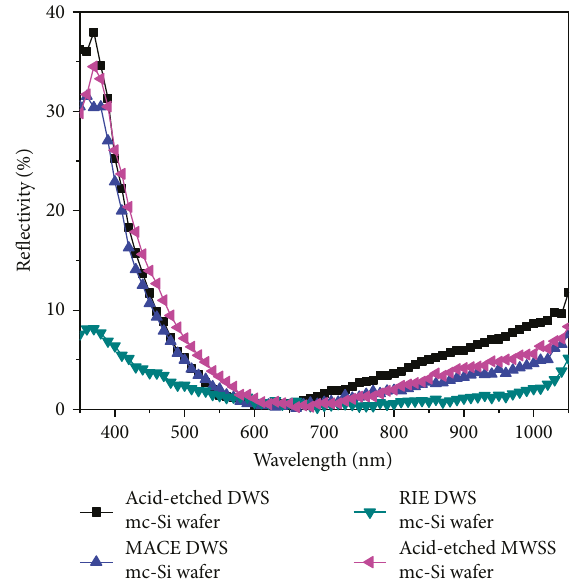
Figure 3: Re fl ectivity versus wavelength curves of SiN-deposited wafers with di ff erent microstructures.